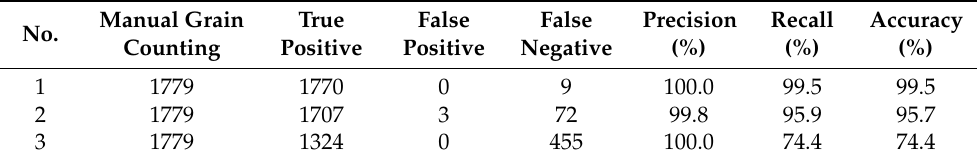
Table 4. The precision, recall and accuracy of the grain detection model (No. 1) and the original Faster R-CNN method (No.2) and SSD method